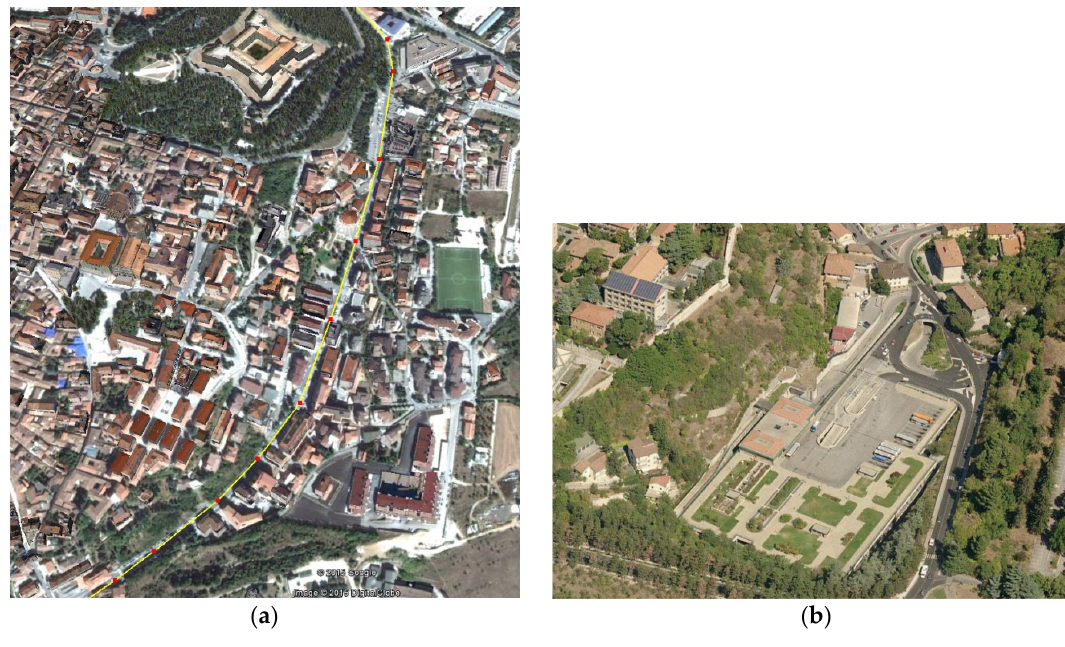
Figure 6. The two urban sites of L’Aquila, where the air remediation tests will be carried out. Strinella street, yellow line ( a ), and Collemaggio parking site ( b ).